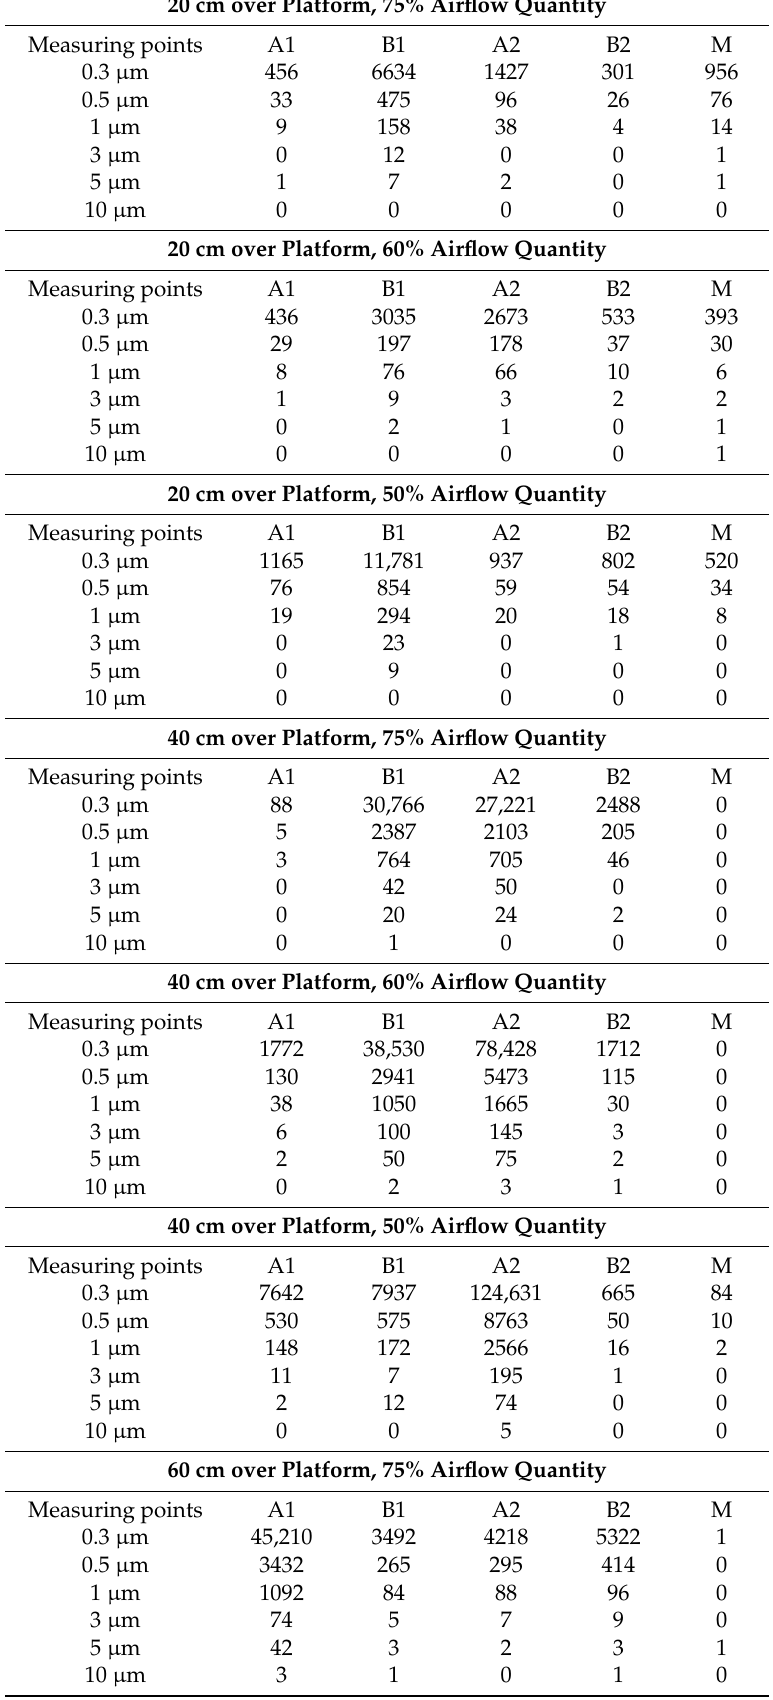
Table 1. Measured concentrations of particles of various sizes at the measuring points given in Figure